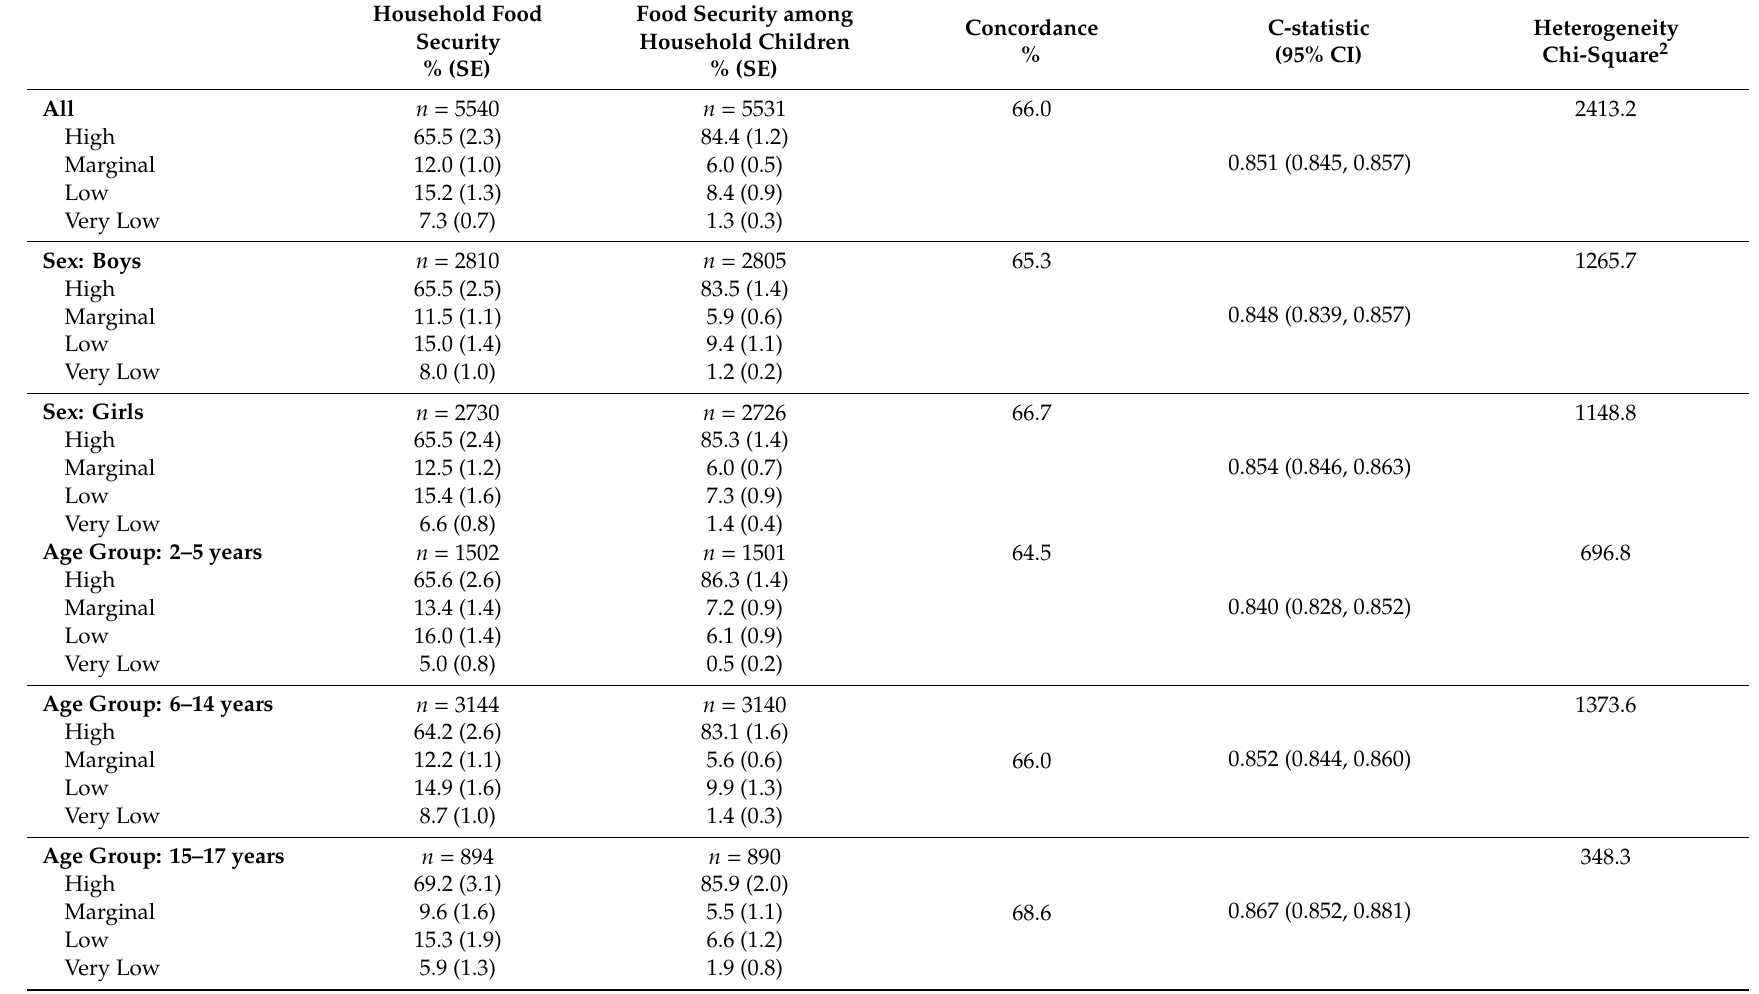
Table 2. Agreement between household food security and food security among household children among U.S. children (2–17 years) 1